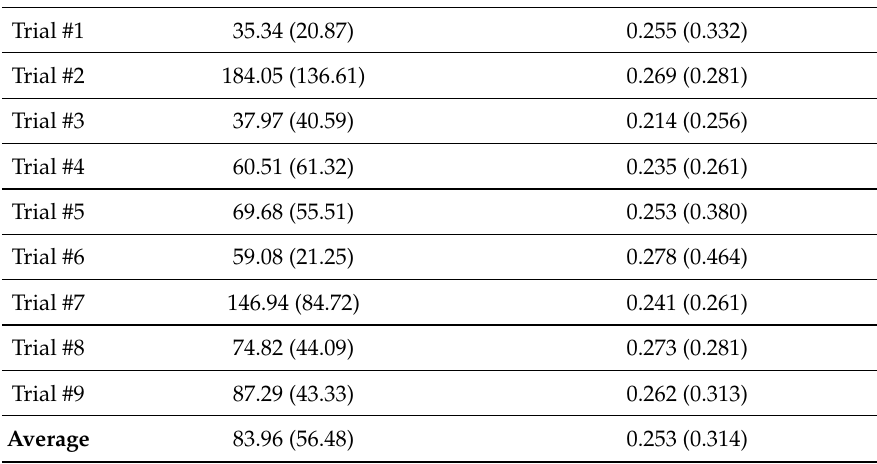
Table 9. L 2 Error (cm) for ground truth positions.